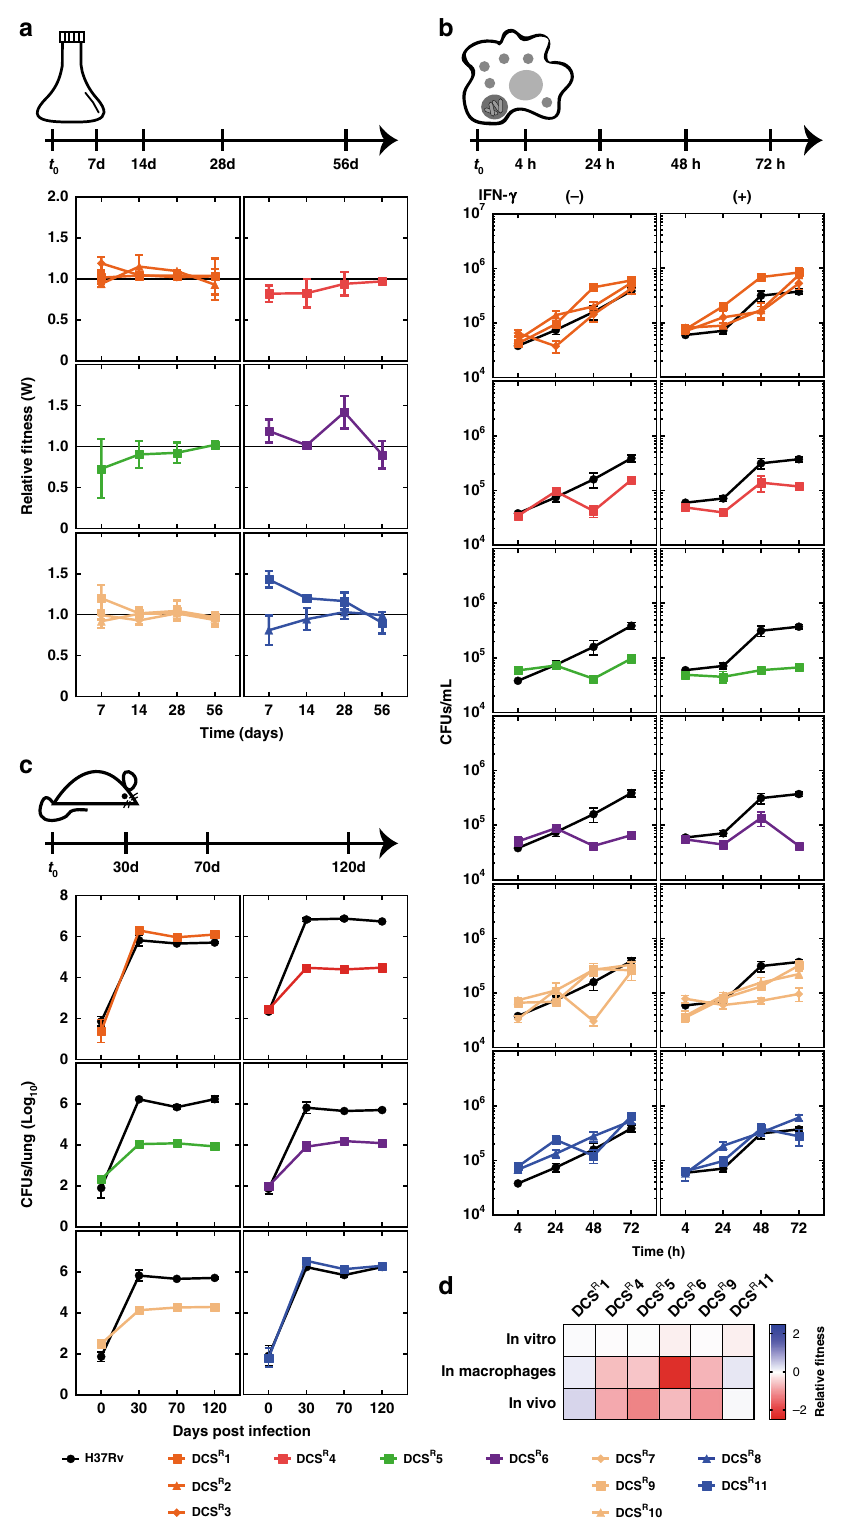
human monocyte-derived macrophages. All DCS R strains tested were taken up similarly by macrophages (Fig. 2b). DCS R 4, bearing solely the D322N Alr mutation, was attenuated during infection of naive and of interferon-gamma-activated human macrophages, compared with the parent strain (Fig. 2b). The presence of the mas V1442G or the ppsA E419K SNPs led to compensatory bene fi ts as strains DCS R 1, DCS R 2, DCS R 3, DCS R 7,